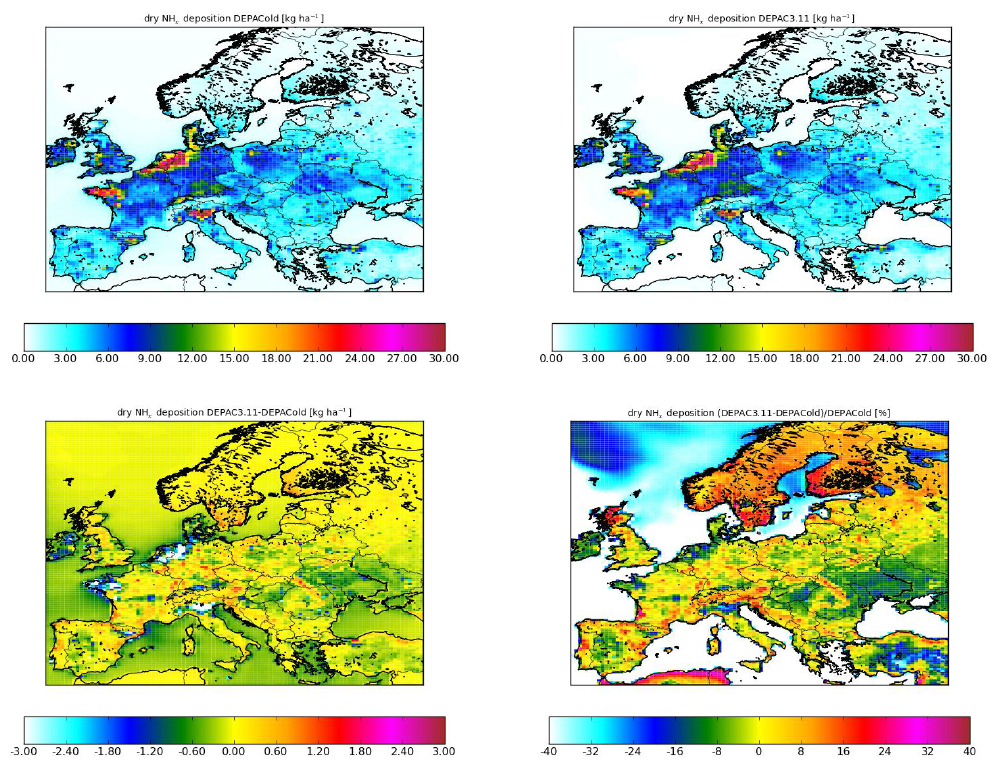
Figure 4. The yearly mean dry NH deposition as calculated by the LOTOS-EUROS model with the Fig. 4. The yearly mean dry NH x deposition as calculated by the LOTOS-EUROS model with the DEPACold (upper left) and DEPAC3.11 x 'DEPACold' (upper left) and 'DEPAC3.11' module (upper right) for the year 2007. The lower left module (upper right) for the year 2007. The lower left figure shows the absolute difference, and the lower right figure shows the relative figure shows the absolute difference and the lower right figure shows the relative difference between difference between the two model calculations. The grid resolution in these figures is 0.50 ◦ longitude × 0.25 ◦ latitude ( ∼ 28 × 28km 2 ) the two model calculations. The grid resolution in these figures is 0.50° longitude x 0.25° latitude (~28x28 km 2 ).